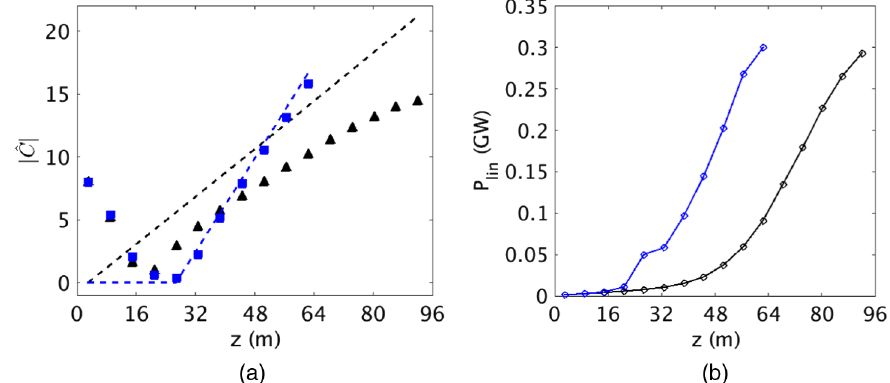
FIG. 8. (a) The magnitude of the normalized detuning parameter without a frequency shift (dashed lines) and the simulation results with black triangles (existing method) and blue square markers (modified reverse tapering). (b) The linearly polarized radiation power for the existing method (black lines) and the modified reverse tapering method with N